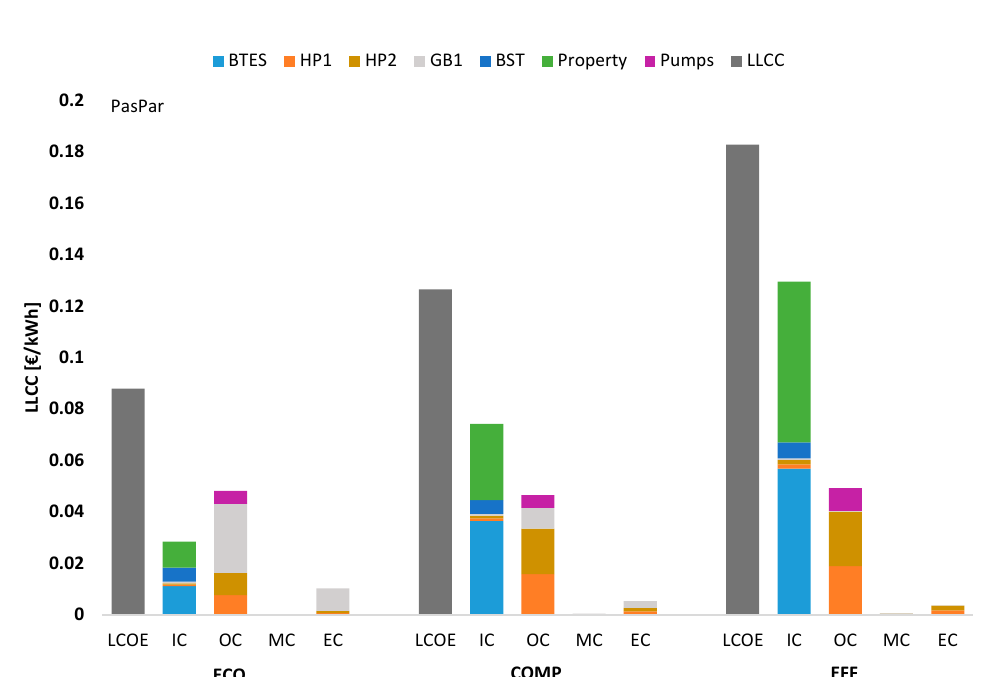
Figure 16. Total and component-wise Levelized Life Cycle Cost (LCOE) of PasPar scenario; LCOE is the summation of Initial Cost (IC), Operational Cost (OC), Maintenance Cost (MC) and Emission Cost (EC) for the economical (ECO), the compromise (COMP) and the most efficient (EFF) designs.